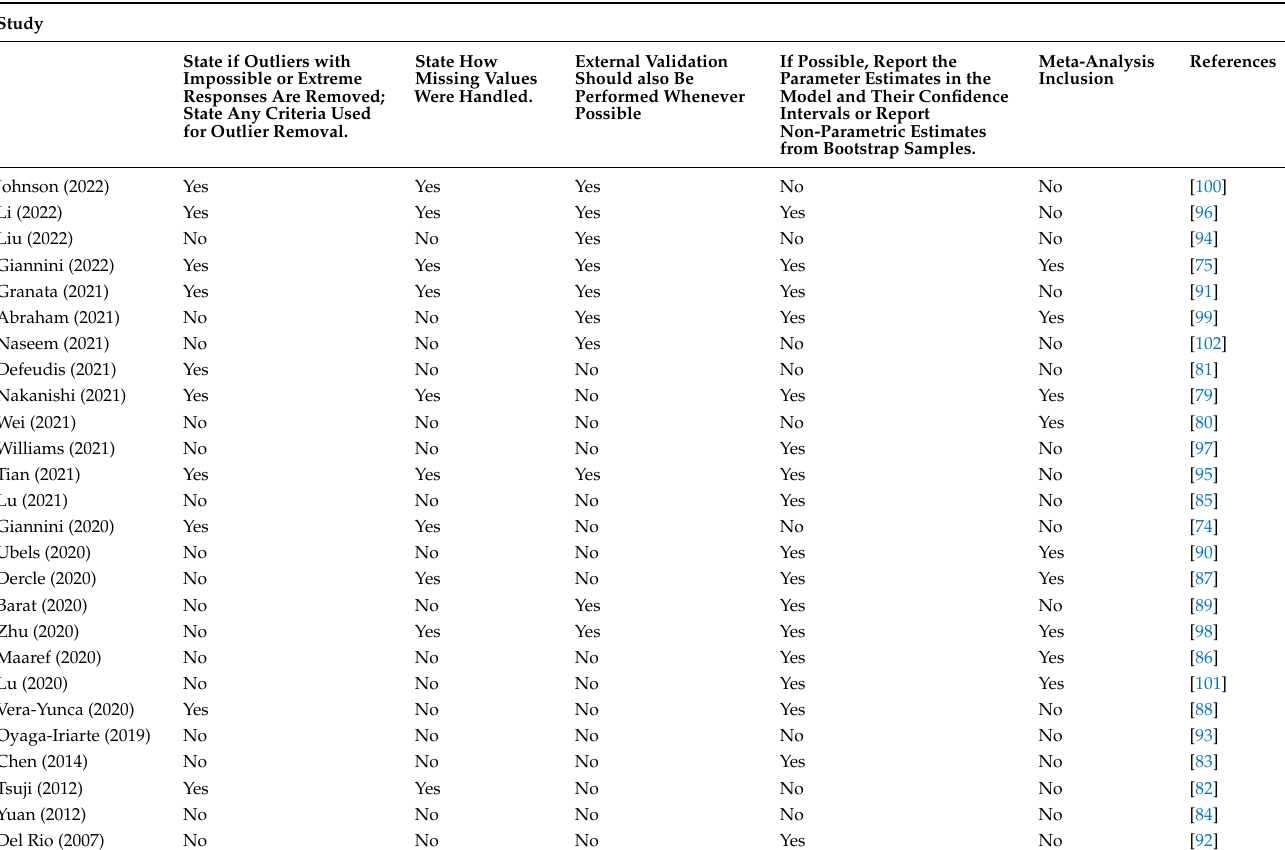
Table 4. Least frequently met study quality items modified by Brnabic and Hess